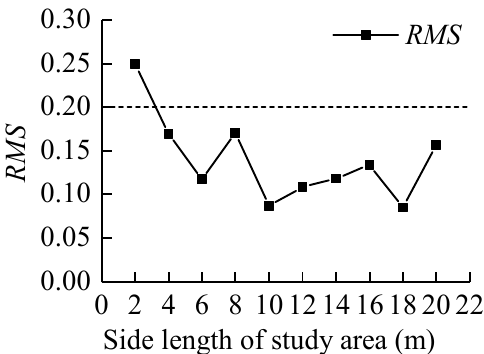
Figure 8. Variation of the Root Mean Square ( RMS ) with the study area.